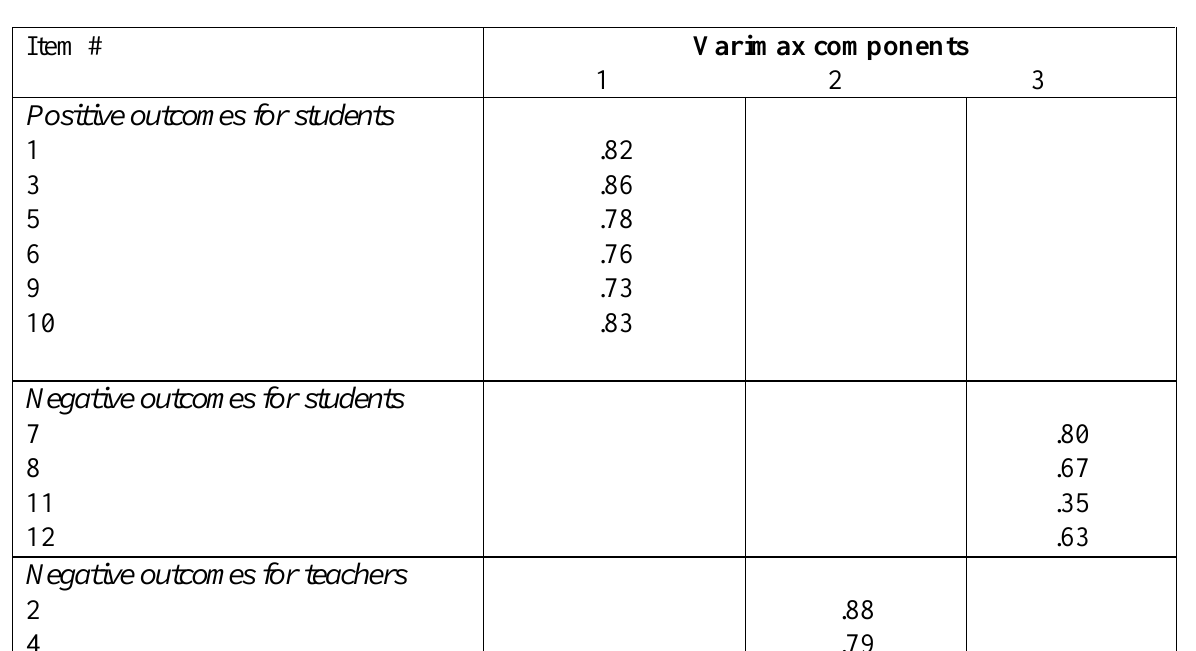
Table 6 Component loadings, eigenvalues and percentages of variance using principal components extraction with varimax rotation for total composite